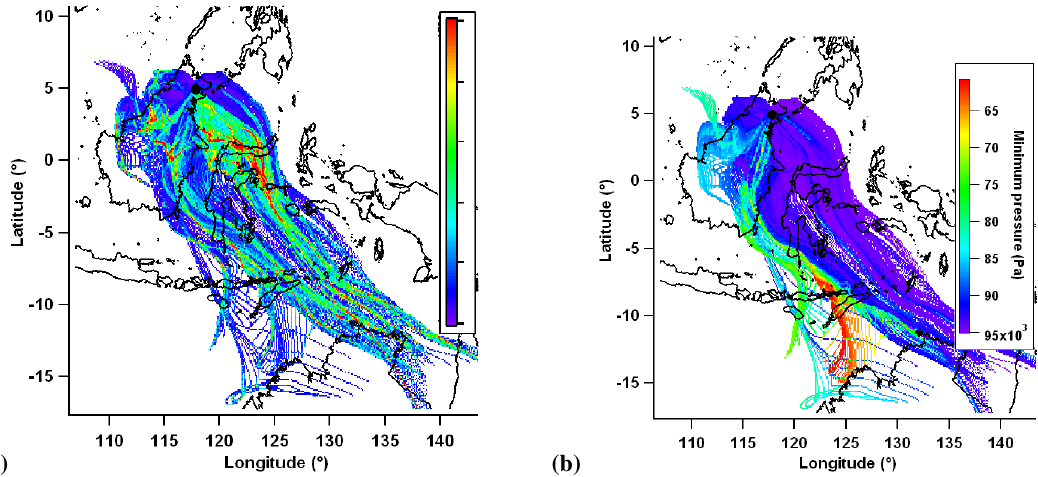
Fig. 8. (a) Residence time of air masses in previous 7 d for all trajectories during OP3-III. Colour is number of trajectory data points (normalised to geometric probability density function). (b) mean minimum pressure of trajectories passing through that cell in in previous 7 d. Trajectory receptor site (the measurement site) marked with a black dot.